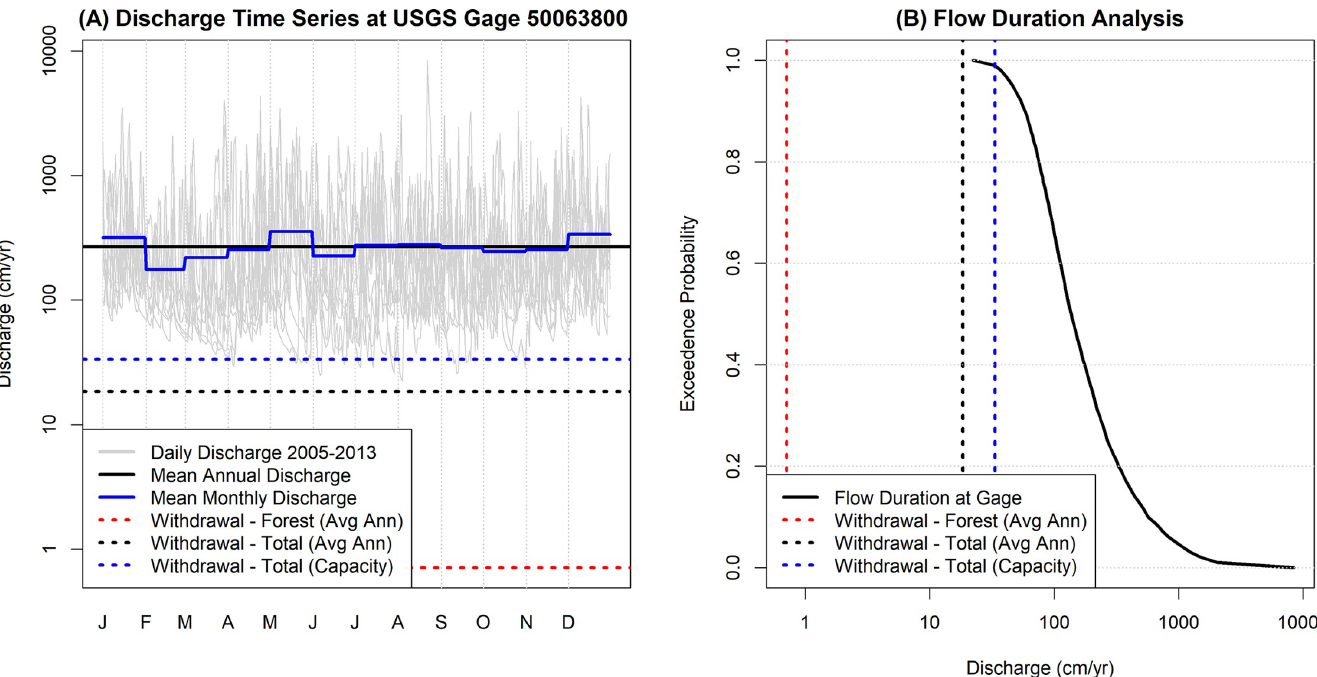
Fig 3. Sample hydrograph from Rio Espiritu Santo (USGS Gage No. 50063800) for 2005–2013.